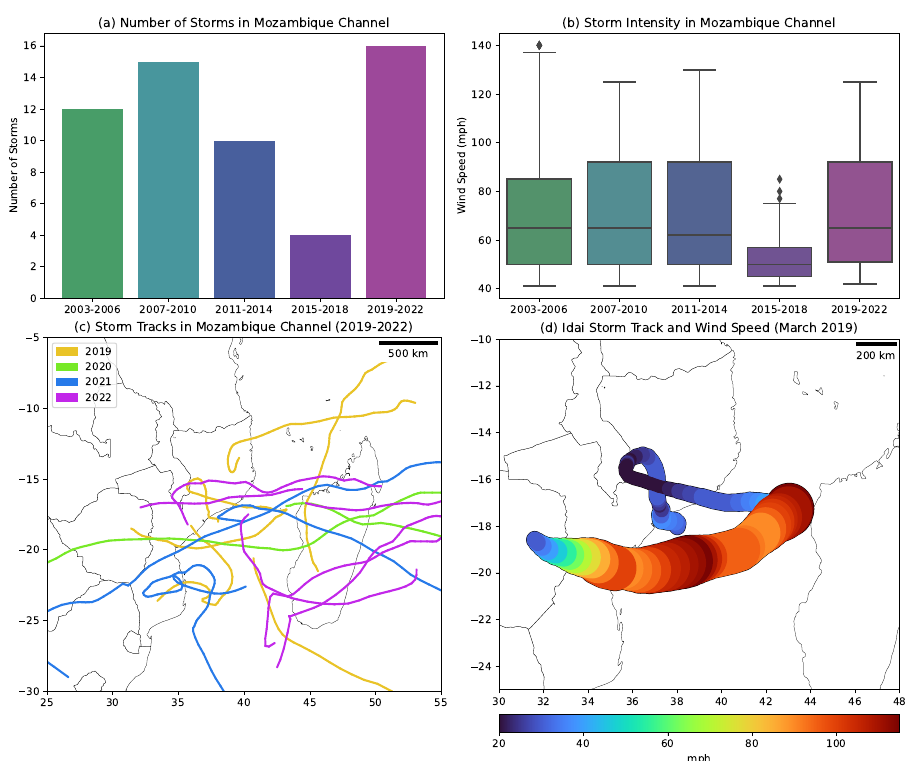
Figure 10. Cyclone activity in the Mozambique Channel: ( a ) the number of storms grouped by 4-year periods, ( b ) wind speed statistics for the 4-year clustered storms, ( c ) storm tracks for the storms that occurred during the 2019–2022 study period, and ( d ) storm track and wind speed of the Idai cyclone (March 2019), the most significant storm within the study